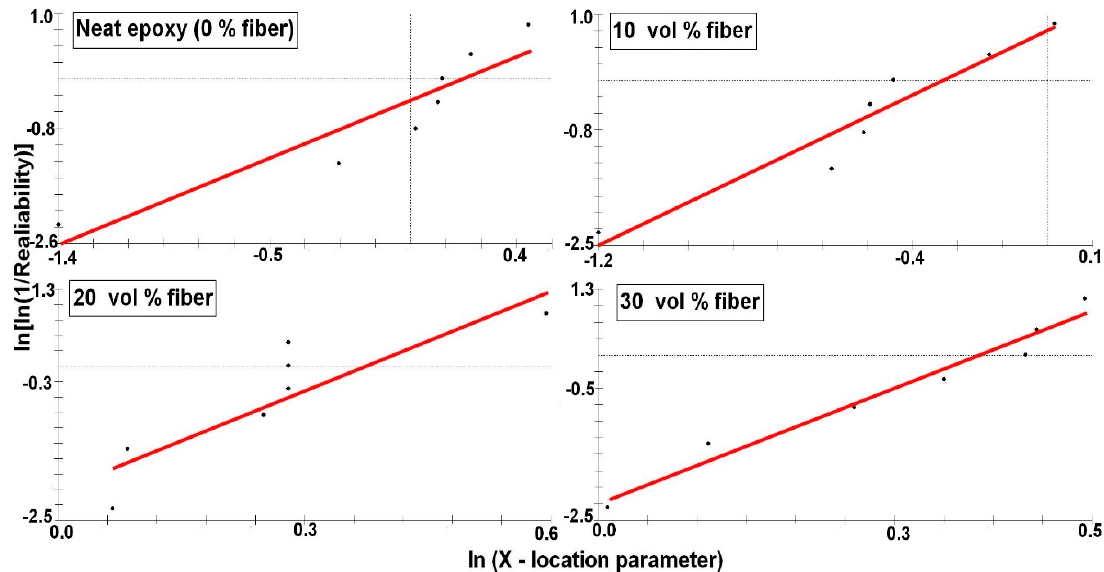
Figure 8. E lastic modulus Weibull plots for the epoxy composites reinforced with different volume fractions of caranan fiber.